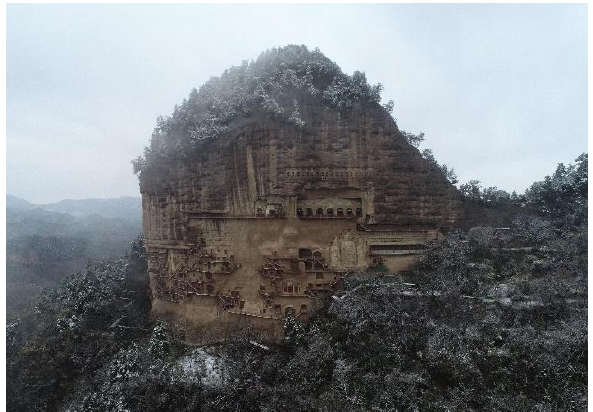
Figure 2. Maijishan Grottoes